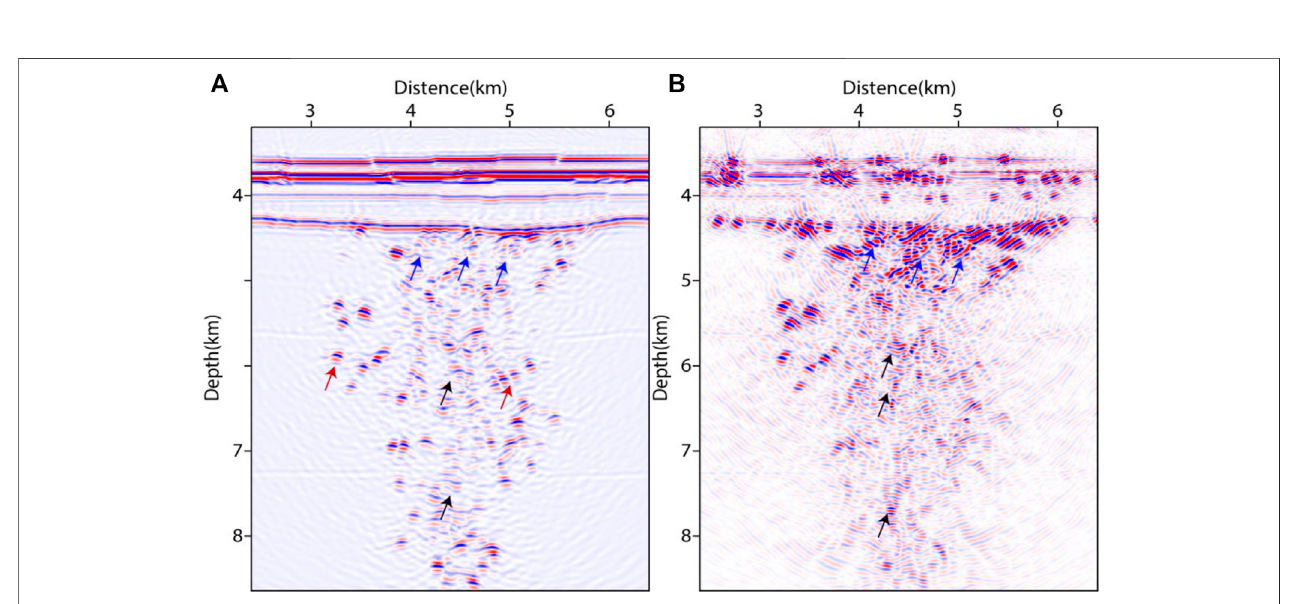
FIGURE 17 | LSRTM images after 20 iterations. (A) AS-F-LSRTM and (B) AS-D-LSRTM.